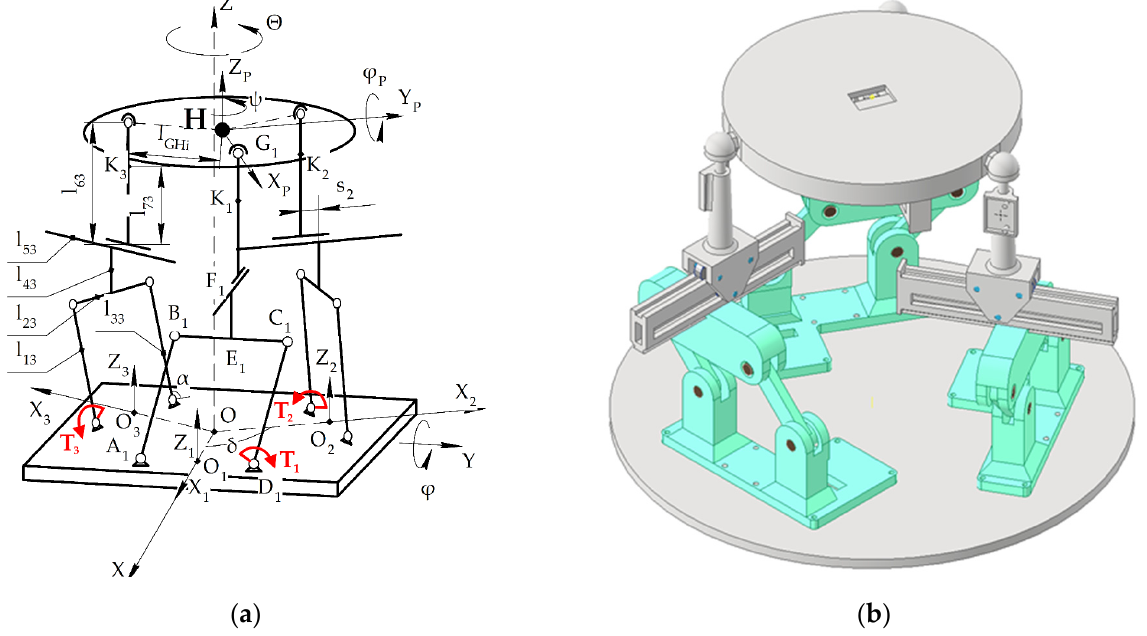
Figure 2. A design scheme of L-CaPaMan2 solution: (a) the scheme; (b) CAD design